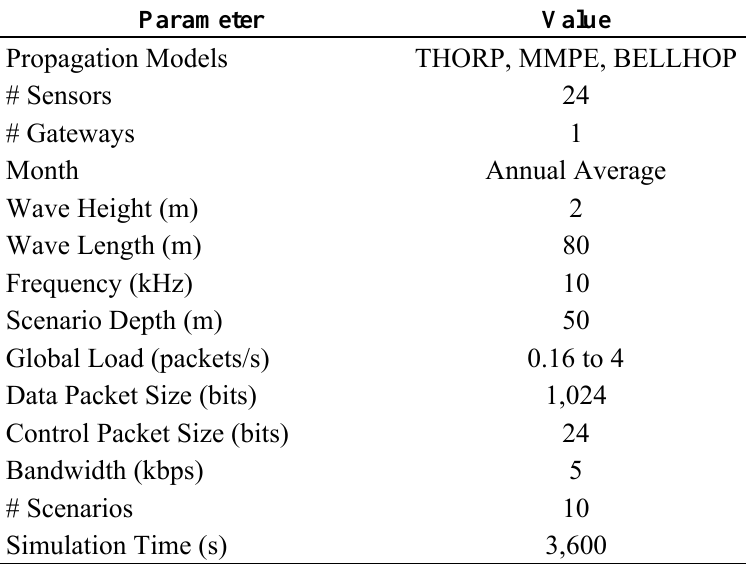
Table 1. Simulation and network scenario